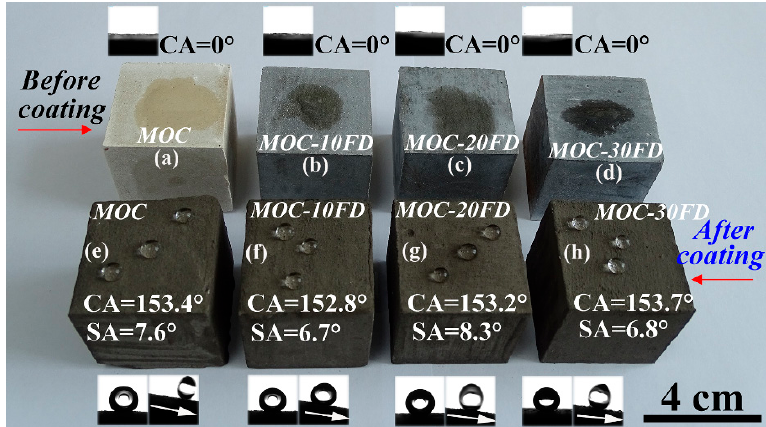
Figure 5. Photograph of the wetting behavior of water droplets on various FD/MOC composite surfaces. ( a )–( d ) before coating treatment; ( e )–( h ) after coating treatment. The inset show the CA and/or SA measurement.